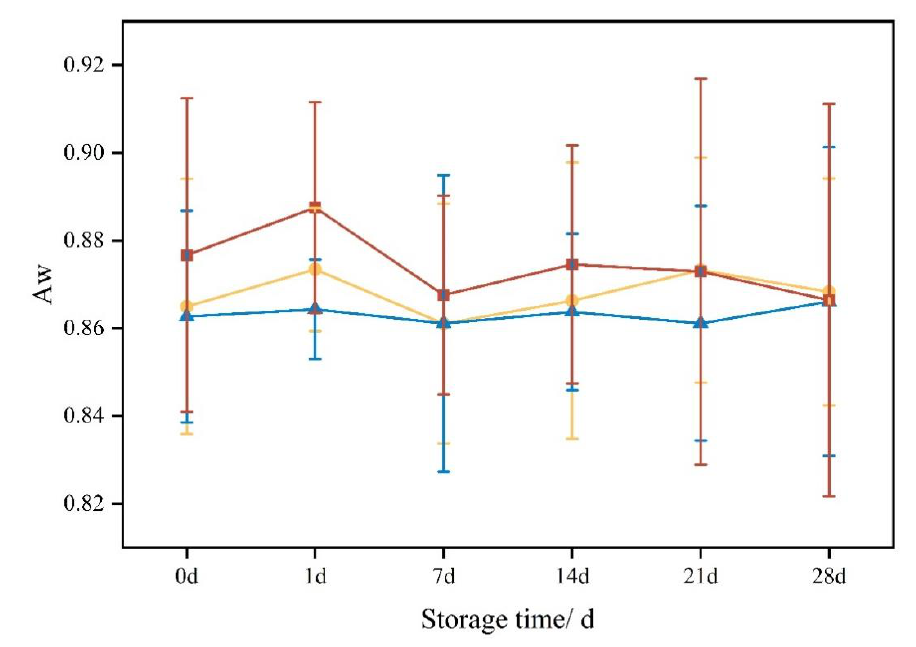
Figure 3. Change trend of Aw value of lamb liver paste during storage period. Note: yellow repre- sents the natural fermentation group (NF); blue represents the starter fermentation group (SF); red represents the sterilization group (ST).